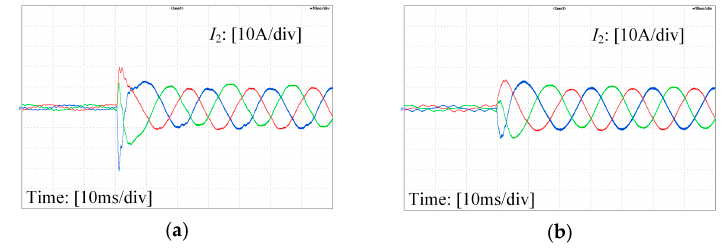
Figure 14. Grid-connected converter starting in rectifier mode with NFF. ( a ) SCR = 10; ( b ) SCR = 2.